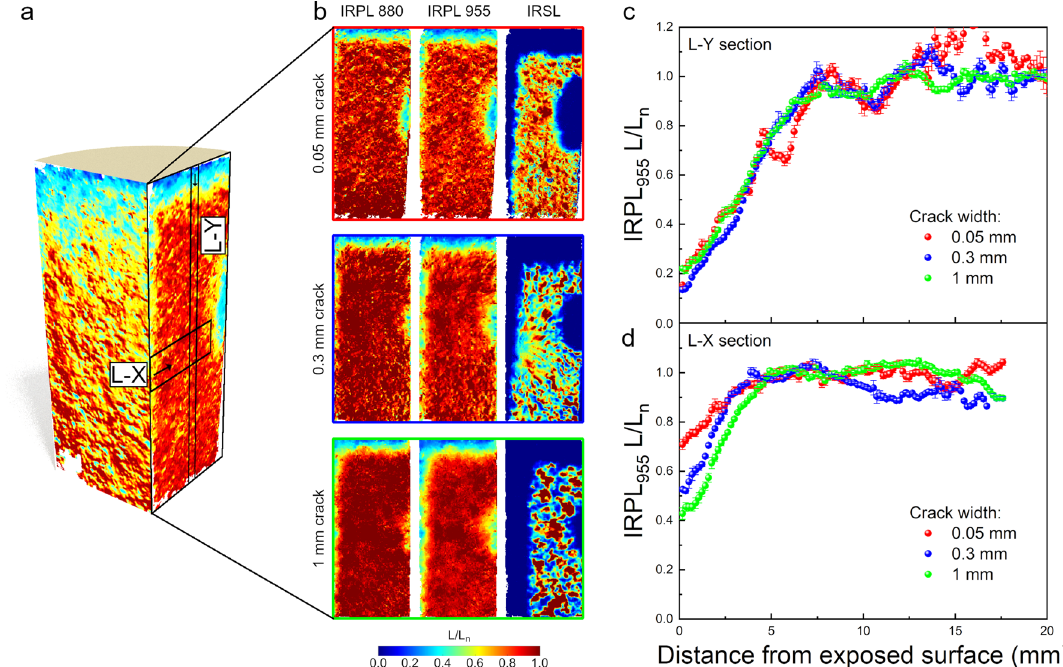
Figure 5. Luminescence measurements on the perpendicular cut surfaces. ( a ) Schematic representation of the perpendicular cut. ( b ) IRPL 880/955 and IRSL maps of the perpendicular cuts of different crack widths. ( c ) Depth profiles taken from the IRPL 955 luminescence values from the top surface (L-Y section). ( d ) Depth profiles taken from the crack surface (L-X section) at a distance of 25 mm from the top. The data is shown for the different crack